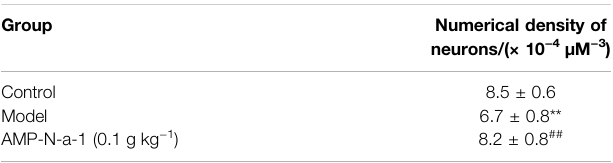
TABLE 4 | Effects of AMP-N-a-1 on the numerical density of neurons in the CA3 regionofthehippocampusinmicewithlearningandmemorydisorder( n =18, mean ±